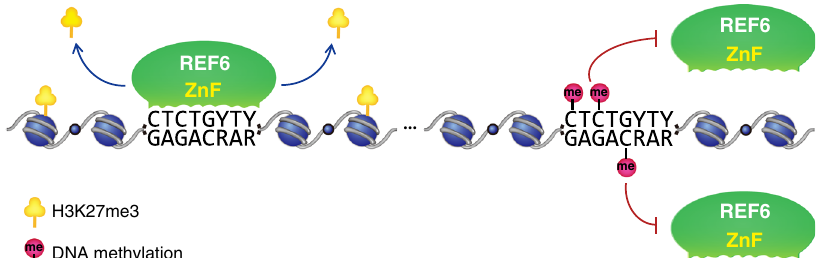
Fig. 6 Model of how DNA methylation prevents REF6 binding to the CTCTGYTY motif NATURE COMMUNICATIONS| (2019) 10:2063